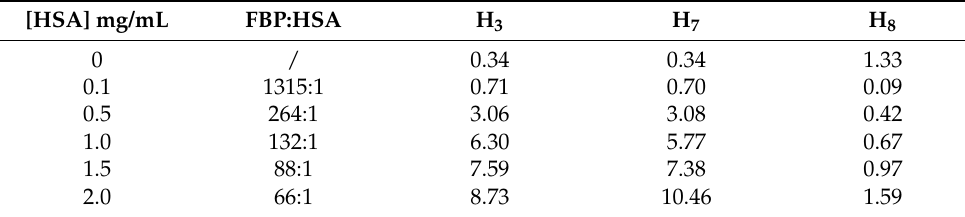
Table 3. 1 H mono-selective relaxation rates R 1ms (s −1 ) (600 MHz, 25 °C, D 2 O, pH = 7.4) of some protons of FBP (2 mM) in its free state and normalized mono- selective relaxation rates (ΔR 1ms /R f , ΔR 1ms = R obs − R f ) of FBP protons in mixtures with HSA at different molar ratios.